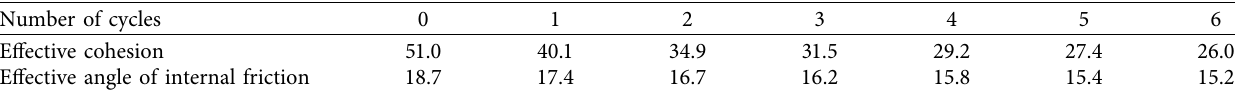
Table 2: Material strength at different cycle times.